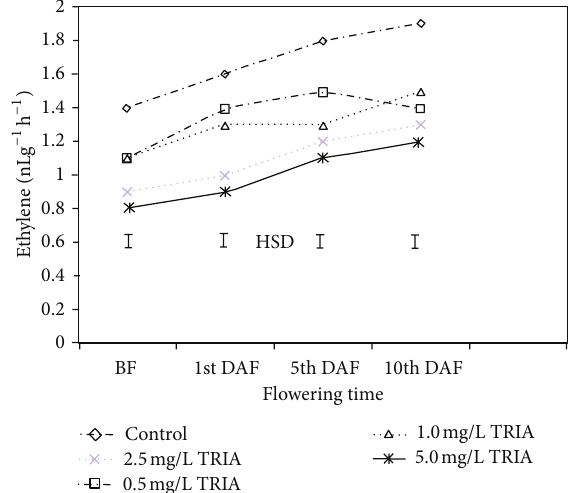
Figure 5: The effect of TRIA treatments on sucrose phosphate synthase (SPS) activity of Bougainvillea glabra leaves. BF: before flowering, DAF: day after flowering.